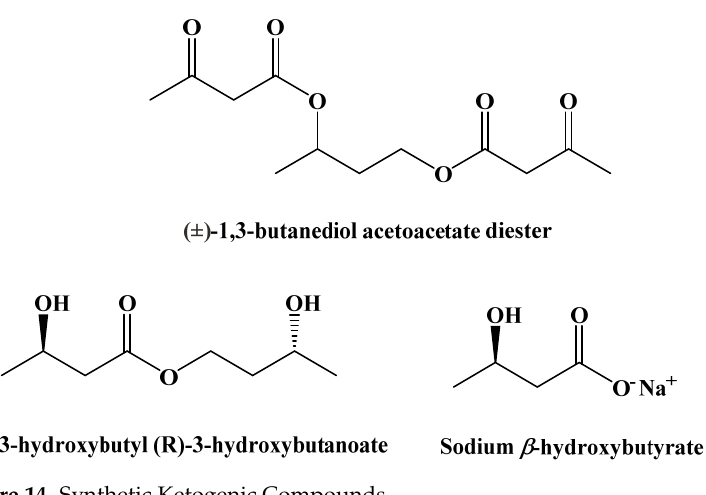
Figure 14. Synthetic Ketogenic Compounds.